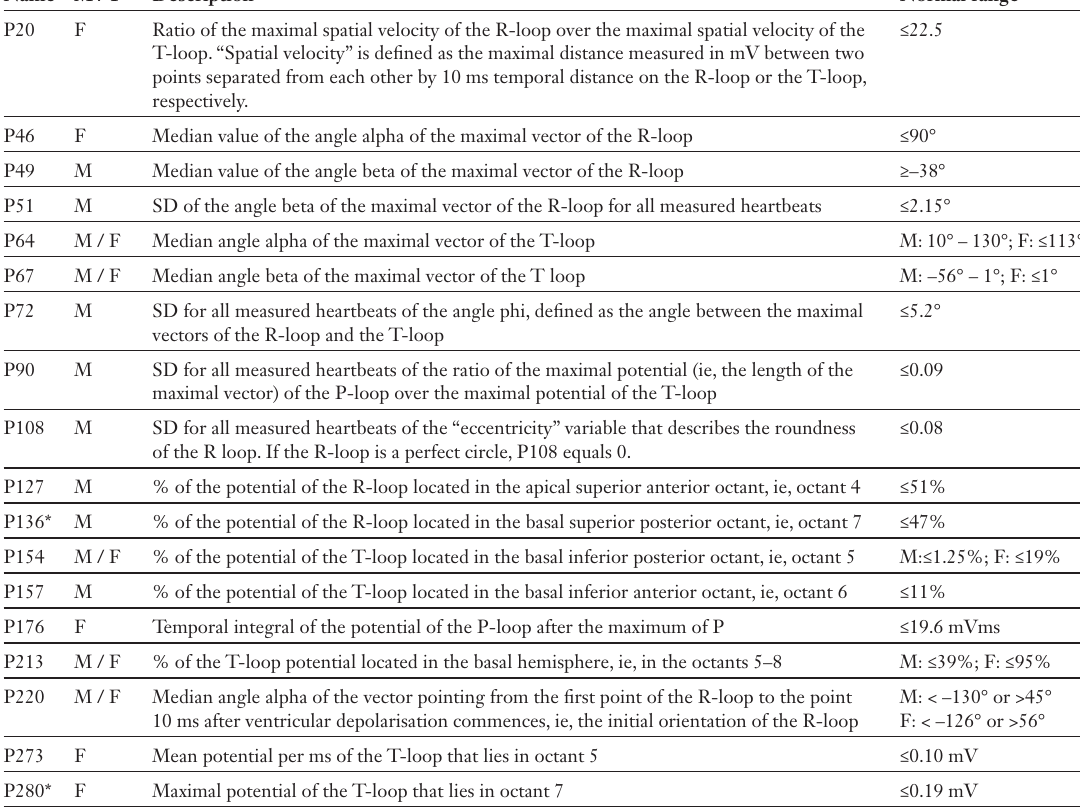
Diagnostic cariables in cardiogoniometry.